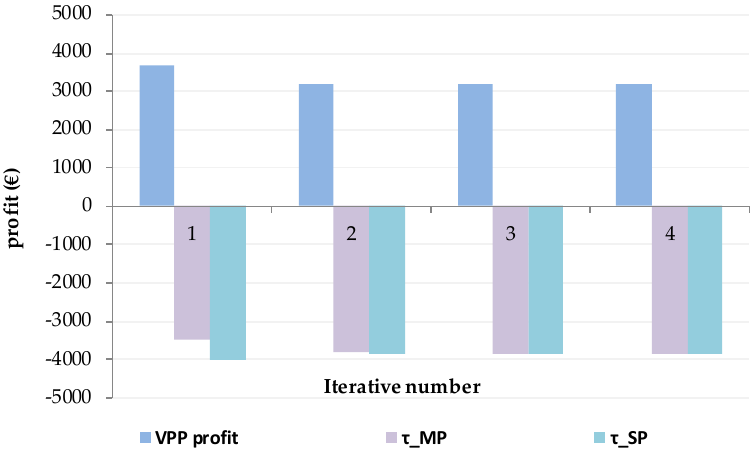
Figure 6. VPP profit and auxiliary variable values obtained at each iteration of the solution algorithm.